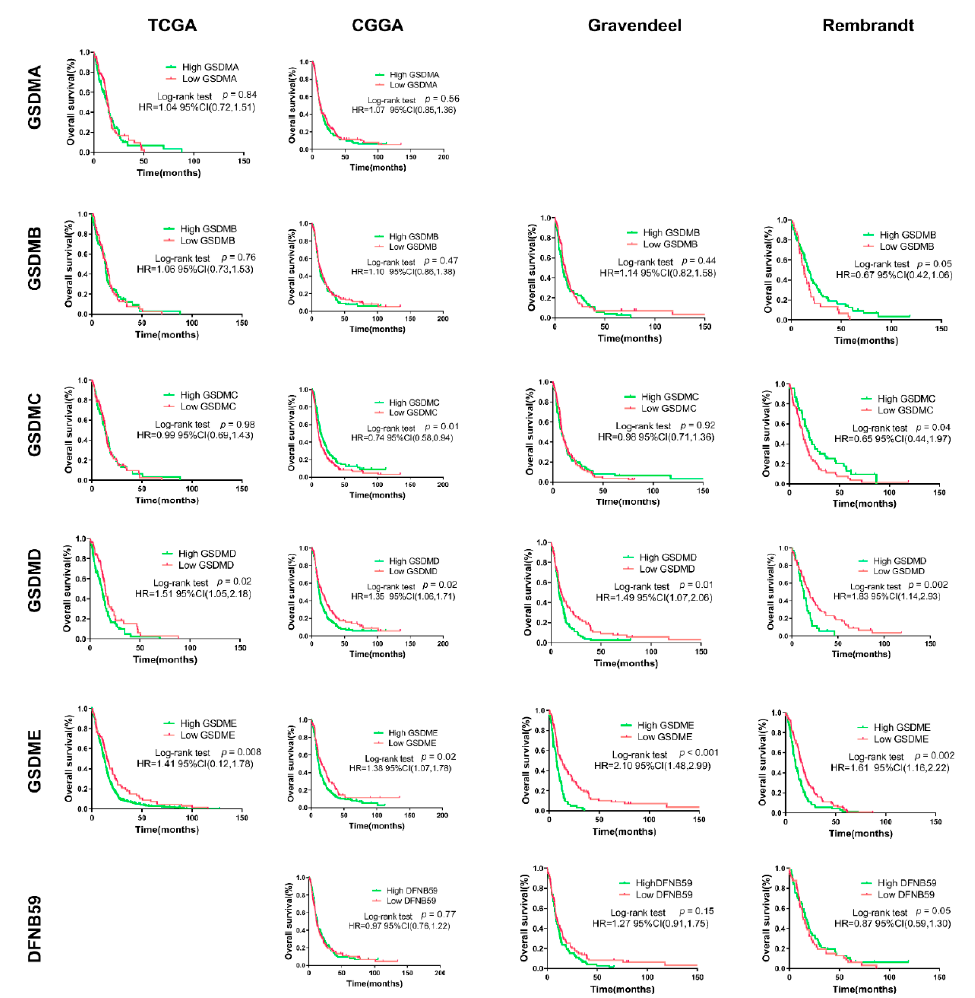
Figure 4. Prognostic role of GSMDs in glioma. Differences in survival between high and low expression in GBM patients were analyzed using Kaplan–Meier analysis with a log-rank significance test. All data were downloaded from GlioVis and optimal cutoff determined using GlioVis. GSDMA expression data was missing in Gravendeel and Rembrandt, while the TCGA-GBM dataset lacked DFNB59 expression. HR, hazard ratio.